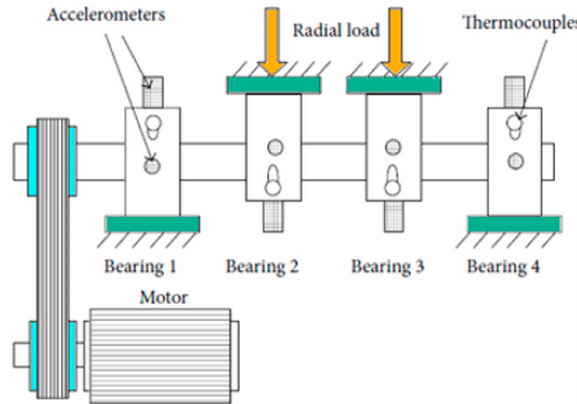
Figure 5. Intelligent maintenance systems (IMS) test rig [45].